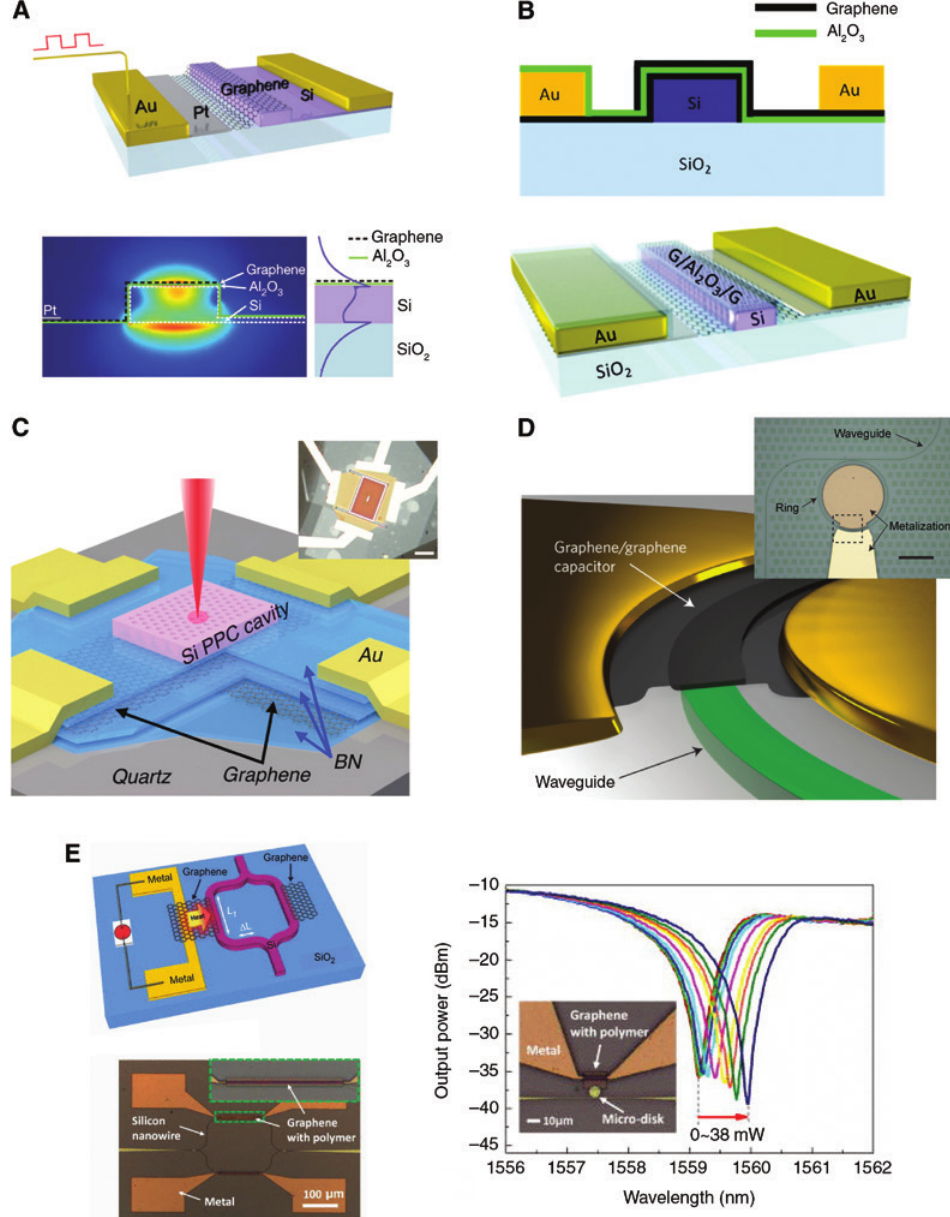
Figure 4: Graphene modulators. (A) First integrated graphene modulator using a doped silicon waveguide to gate the graphene layer. (B) An improved design that uses two graphene sheets to mutually gate the other. This design mitigates free carrier absorption in the waveguide while enhancing the modulation depth by a factor of two for optimally doped graphene sheets. (C) A van der Waals graphene modulator that uses BN as a gate dielectric. A PPC cavity was transferred onto the heterostructure, which enhances optical absorption at the optical resonance. (D) Graphene modulator frequency of 30 GHz. (E) Thermal modulation using graphene as a thermal conductor. High thermal conductivity of graphene allows